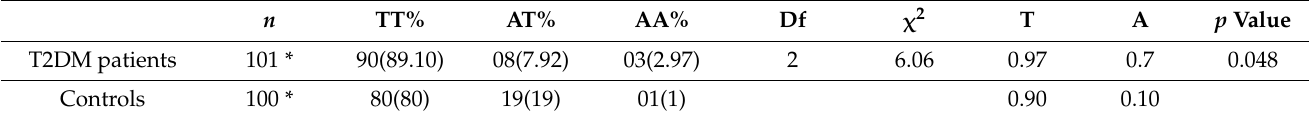
Table 7. GLO-rs1130534 T>A SNP genotypes distribution in patients and